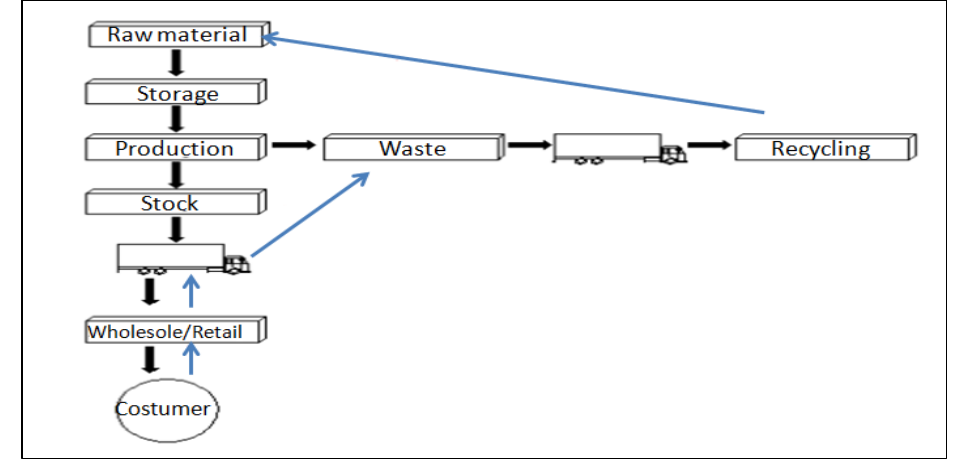
Figure 5: Reverse flow proposed to the studied